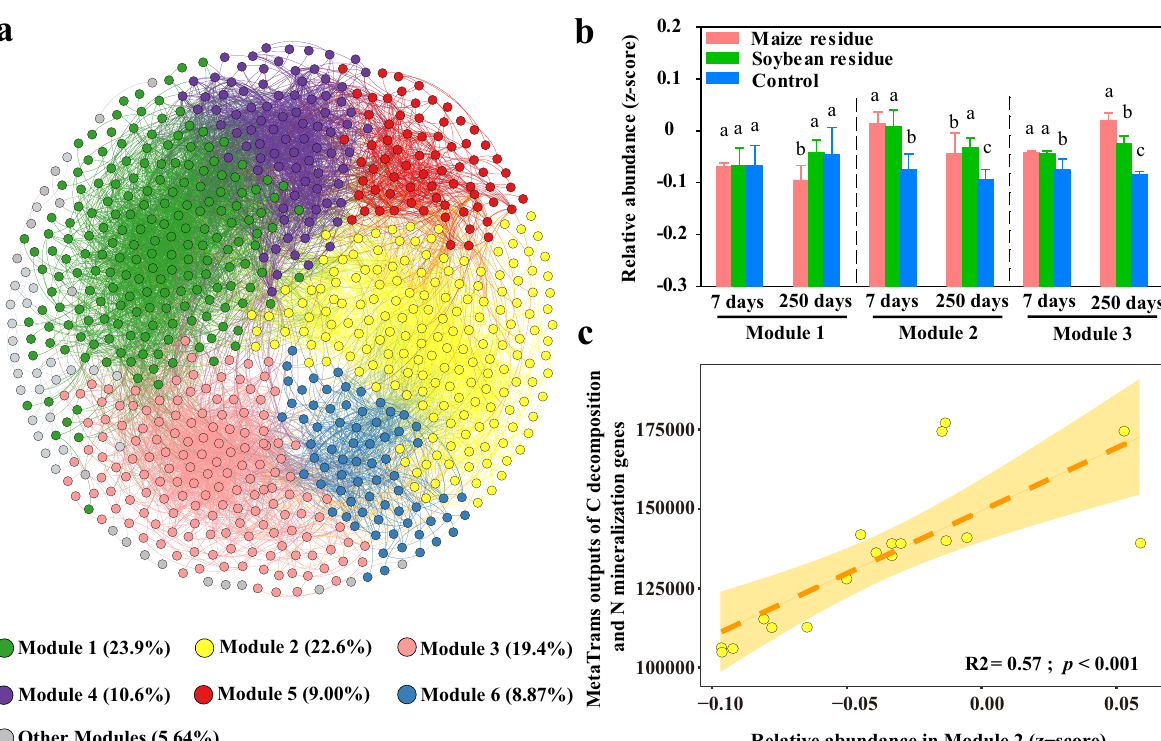
Fig. 6 Ecological clusters based on multitrophic networks. Co-occurrence network diagram with nodes colored according to ecological clusters ( a ); the relative abundance of each module ( b ); the correlations of the relative abundance of Module 2 with normalized reads of C-decomposition and N-mineralization genes ( c ) in a Mollisol amended without (Control) and with maize and soybean residues for 7 and 250 days. Different letters above bars ( b ) indicate signi fi cant differences among treatments at p < 0.05 (one-way ANOVA). Error bars are the standard error of three replicates. The shading area ( c ) indicates 95% con fi dence